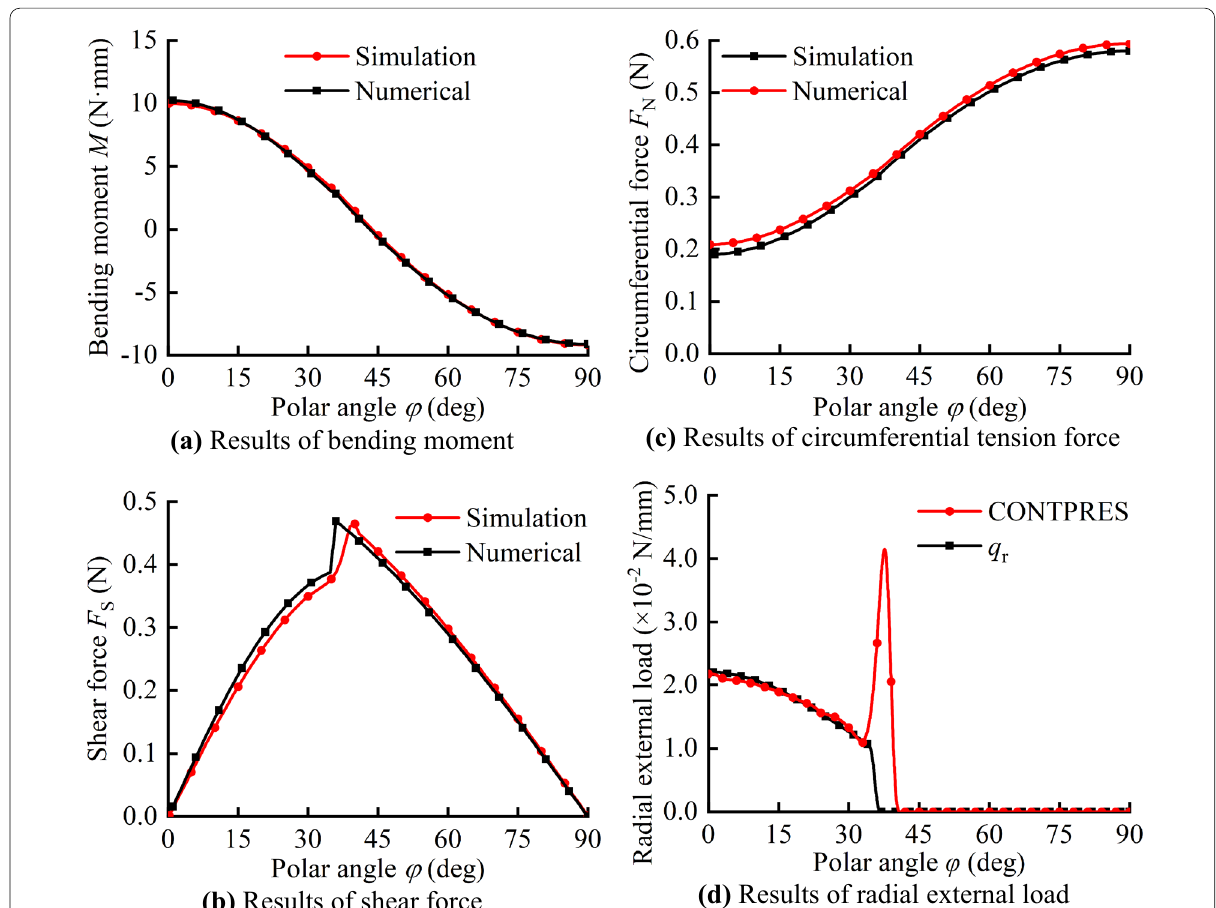
Figure 7 Assembly force of ring under elliptical